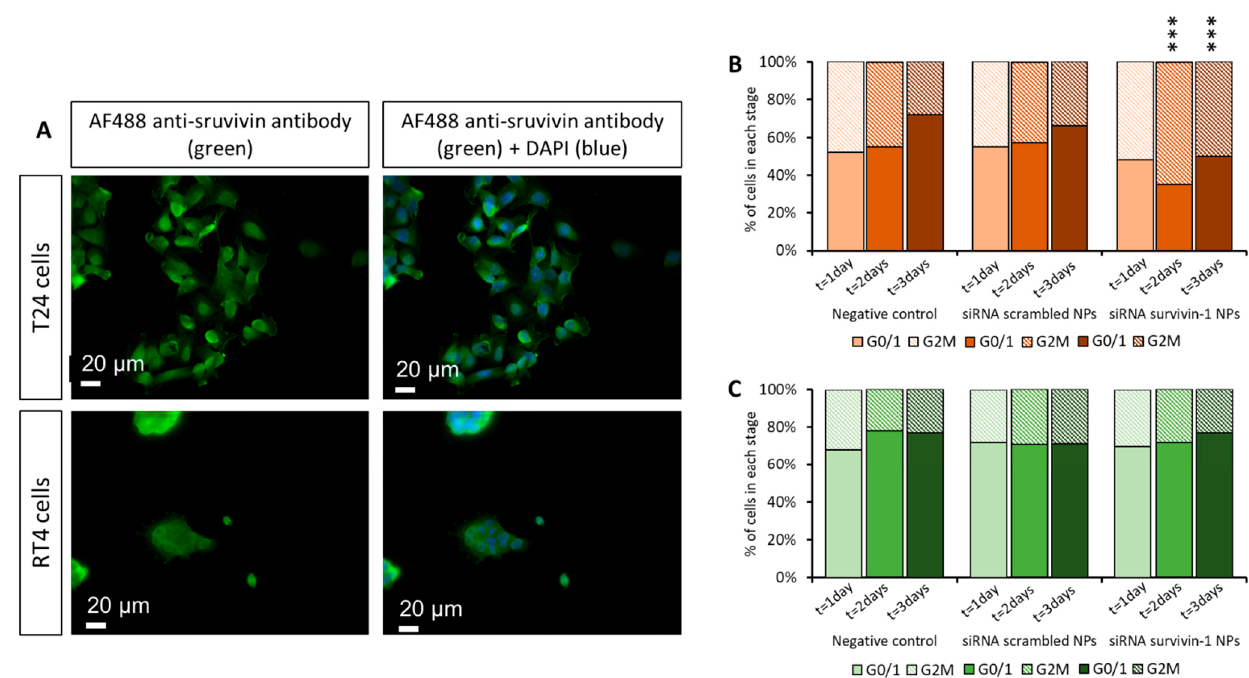
Figure 10. Intracellular and cell cycle studies. ( A )—Fluorescence micrographs of subcellular localization of survivin isoforms as a function of cell type; ( B , C )—Quantification of cell cycle stages of: ( B )—T24 cells and ( C )—RT4 cells, as a function of the treatment and time. Statistical analysis performed to compare results with the negative (non-treated) cells. *** p < 0.001.